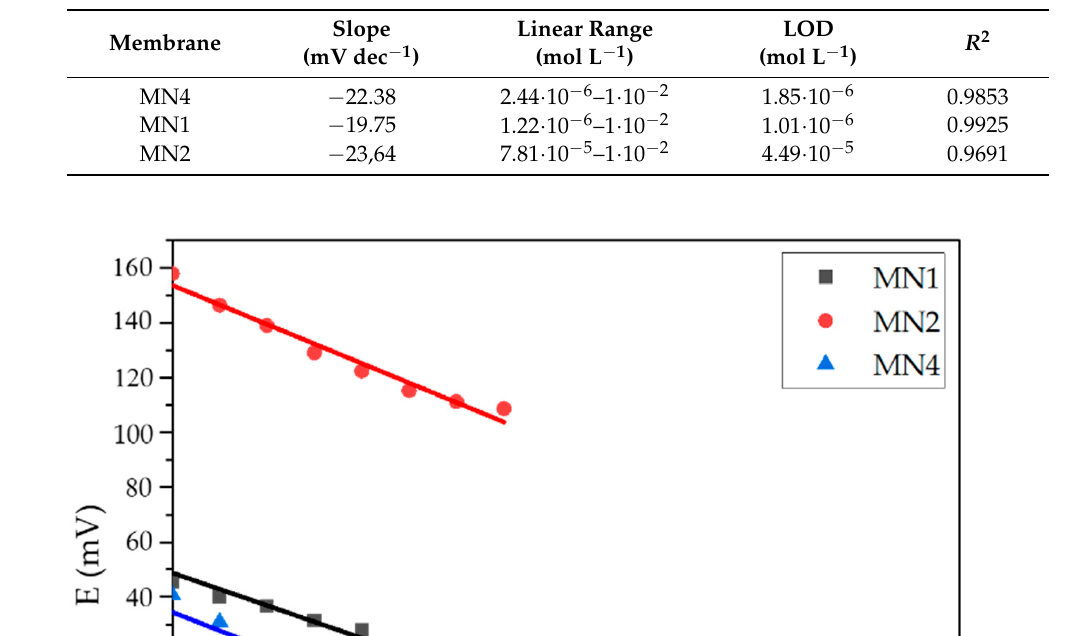
Figure 15. A comparative bar graph for LOD and sesnsitivity values fo MN1, MN2, MN4, MN7, MN8, and MN10 membranes. When analyzing the data from Table 5, the addition of 0.25% hematite had the great- est effect on the extension of the linear dynamic range of the membrane as well as on the detection limit, which plays an important role in this measurement method. As mentioned before, an ideal theoretical slope for trivalent cations determination was established using the Nernst equation and was − 19.3 mV per one concentration decade. Since MN1